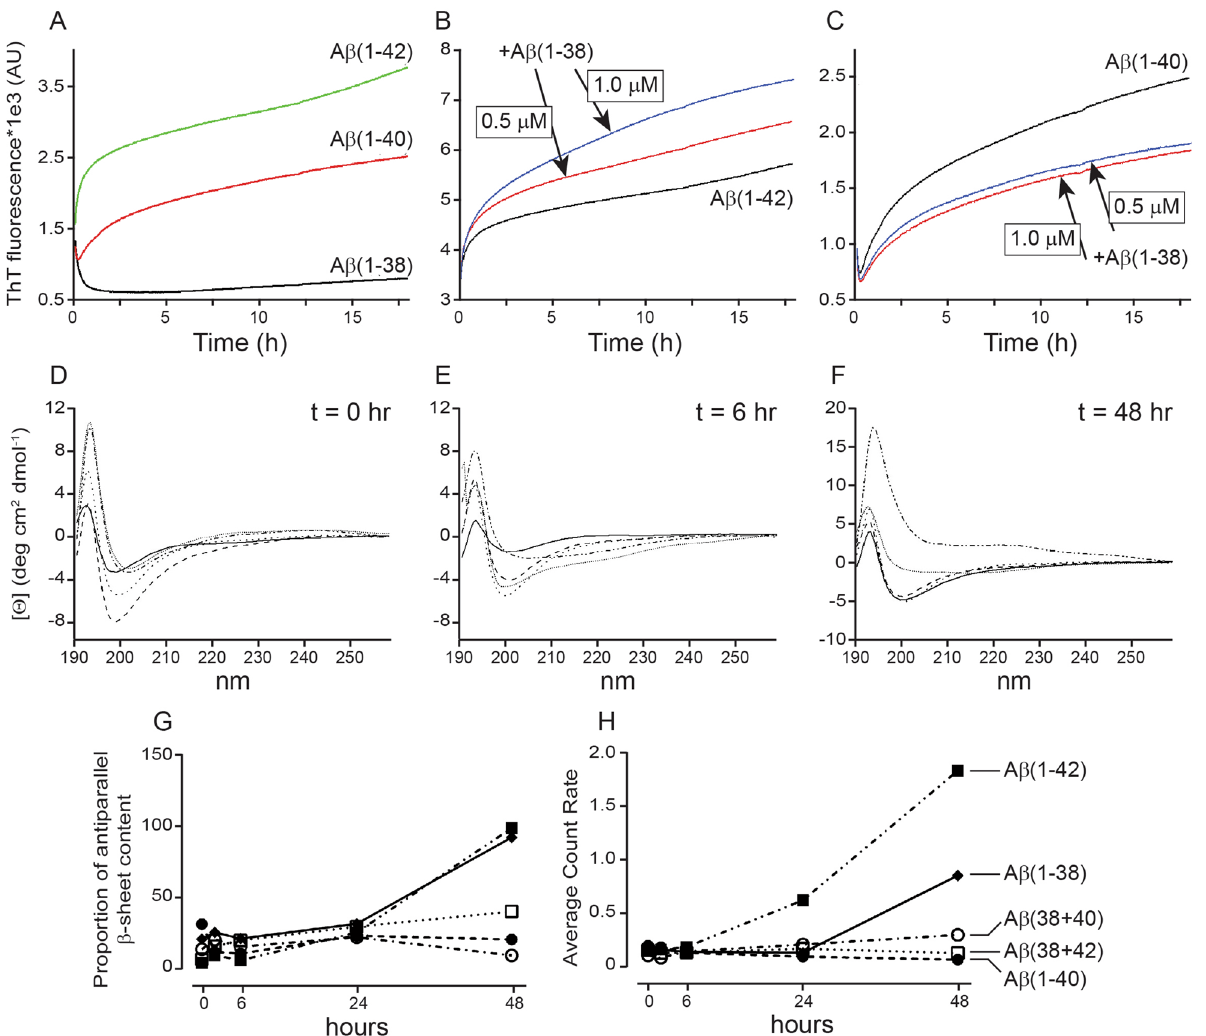
Figure 3. Aβ(1–38) reduces the β-sheet content and aggregation potential of Aβ(1–42). ( A ) ThT binding to Aβ peptides incubated in isolation or as a mixture. 20 µM of ( B ) Aβ(1–42) or ( C ) Aβ(1–40) was co-incubated with either 0.5 or 1 µM of Aβ(1–38) and monitored for ThT fluorescence over time. ( D–G ) CD spectroscopy reveals that the secondary structures of 20 µM Aβ(1–38), Aβ(1–40), and Aβ(1–42) can alter with time ( e.g. 0, 6, and 48 h) and with co-incubation with 1 µM of Aβ(1–38). ( H ) Analysis of the oligomer size distributions of Aβ peptides (20 µM) by DLS reveals similar patterns over time to those captured by CD analysis. The line style in panel H also applies to the CD data in panels D–G . Data represent averages of three separate